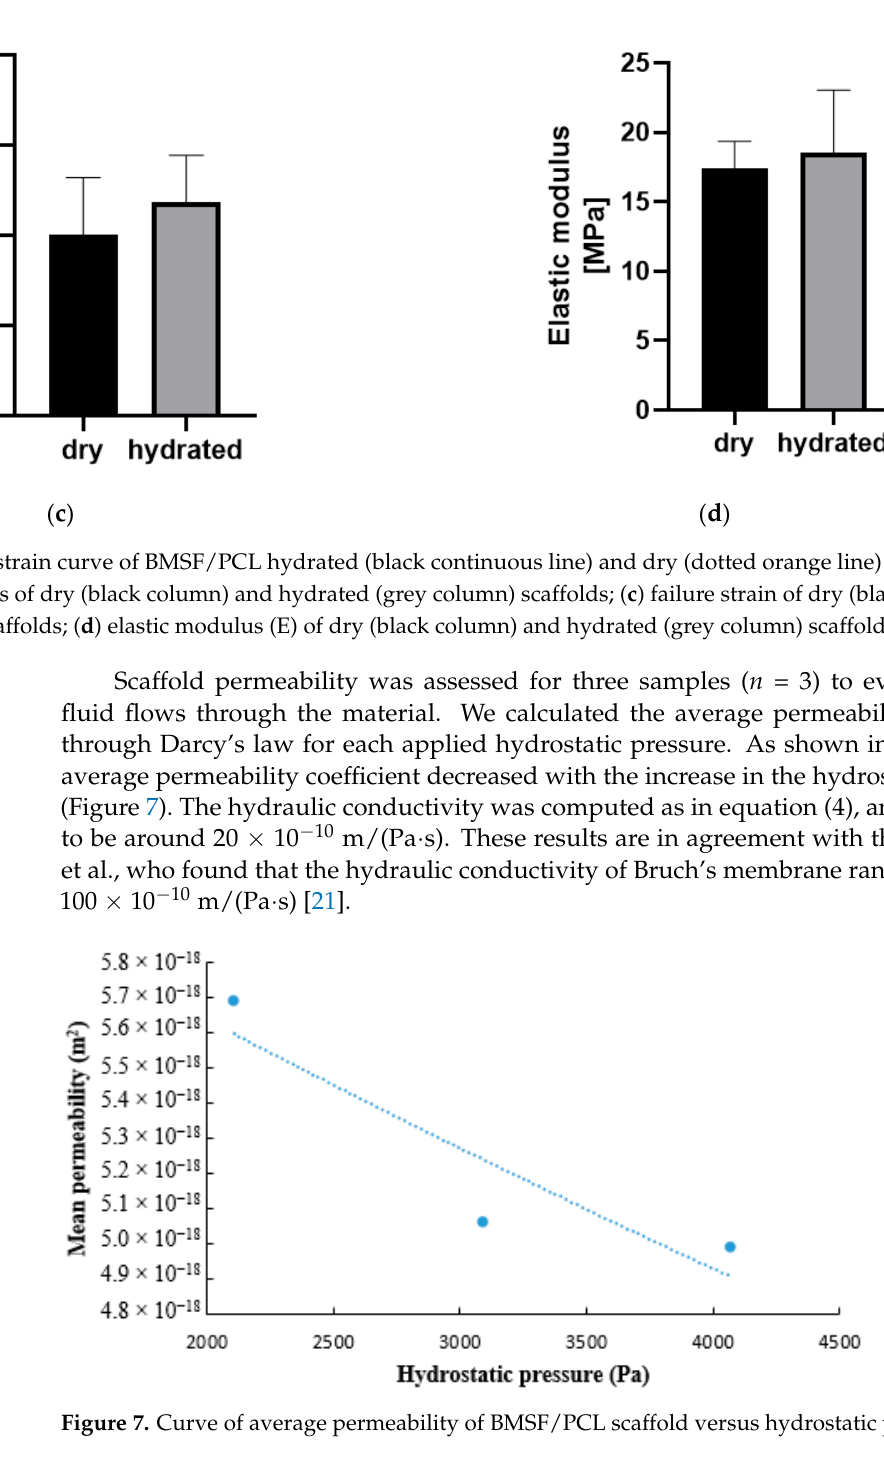
Figure 7. Curve of average permeability of BMSF/PCL scaffold versus hydrostatic pressure.